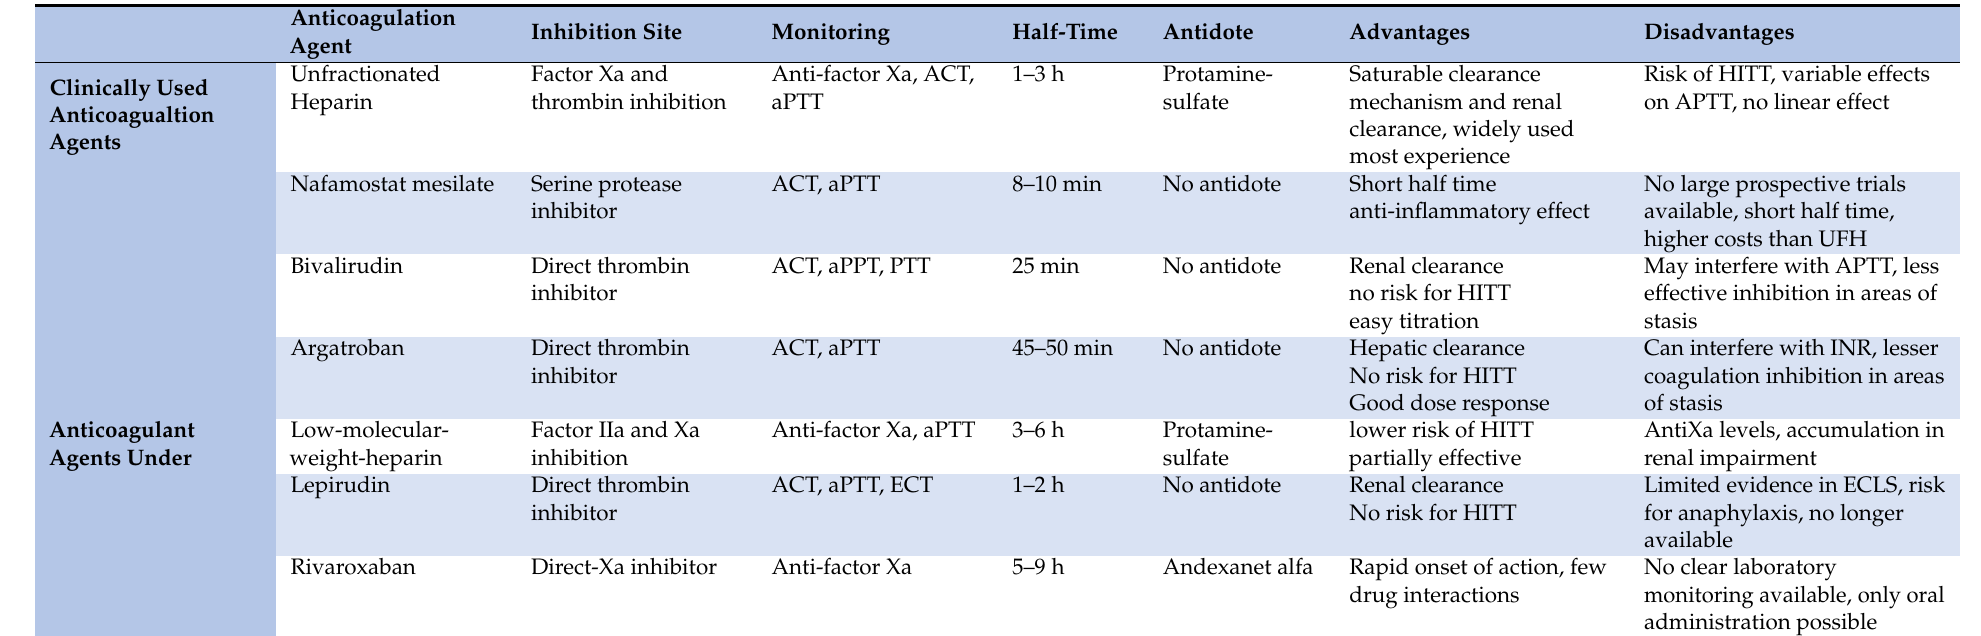
Table 1. Overview of the different anticoagulation agents described for clinical and experimental use in extracorporeal life